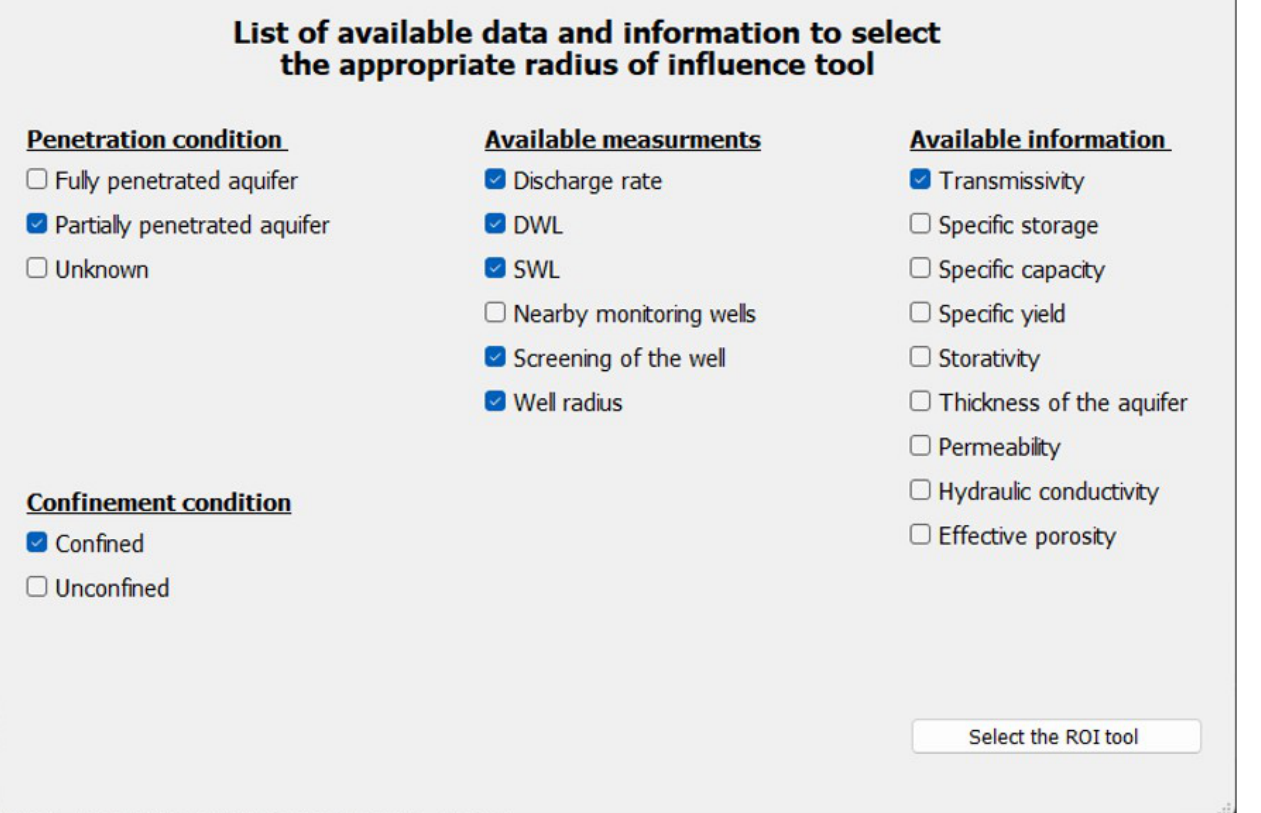
Figure 2. Selecting the appropriate ROI window based on the available data and